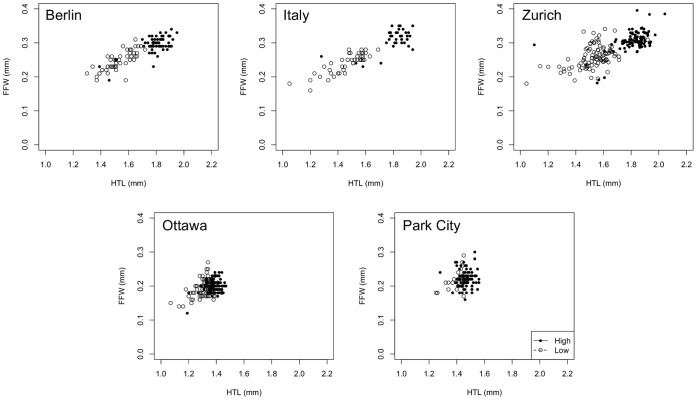
Regression of individual forefemur width on hindtibia length for males reared at high (solid symbols) and low (open symbols) larval food.